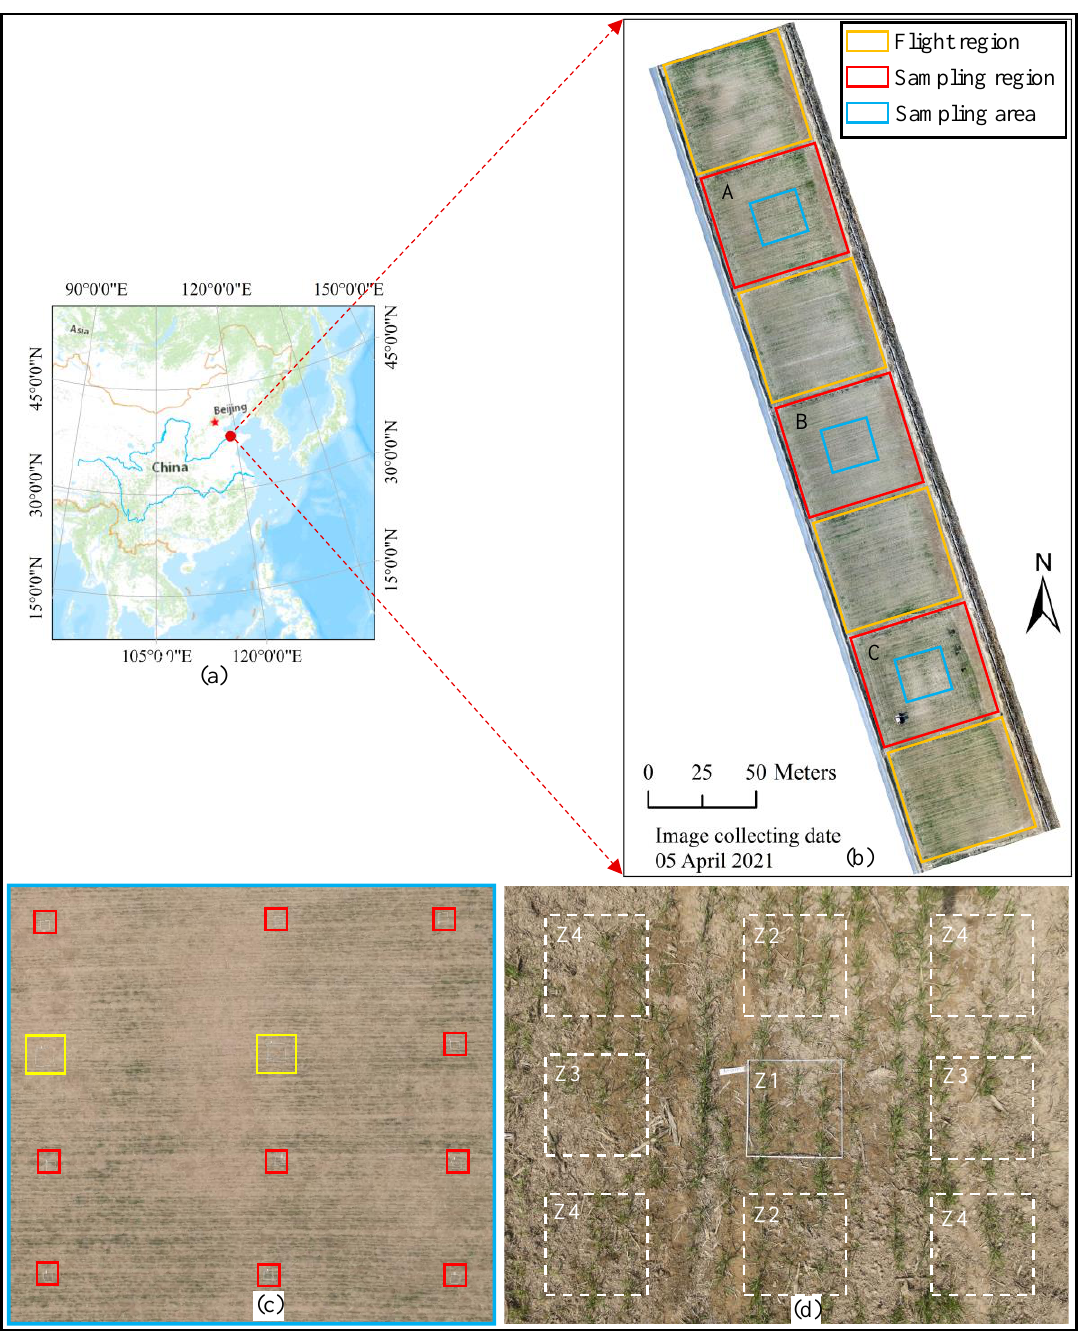
Figure 1. ( a ) Overview of study area location in China. ( b ) Seven patches of wheat farming fields with orange boxes and red boxes represent flight and sampling regions, respectively. The blue box indicates the area containing sampling quadrats with more details in ( c ). ( c ) The distribution of 12 quadrats (ten red boxes indicate ten 0.5 m × 0.5 m sampling quadrats adopted, and two yellow boxes indicate two 1 m × 1 m sampling quadrats abandoned because of unsuitable size for deep learning models). ( d ) A UAV full image with a sampling quadrat located in the center (Z1) and other eight quadrat-distributing locations on corresponding images indicated by white dash boxes (Z2, Z3, and Z4).